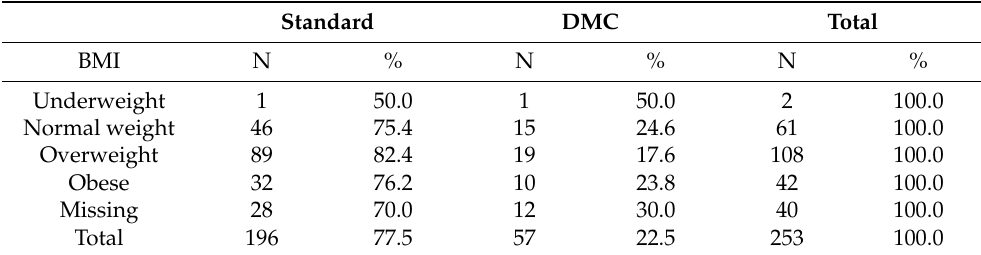
Table 3. Implants divided by BMI